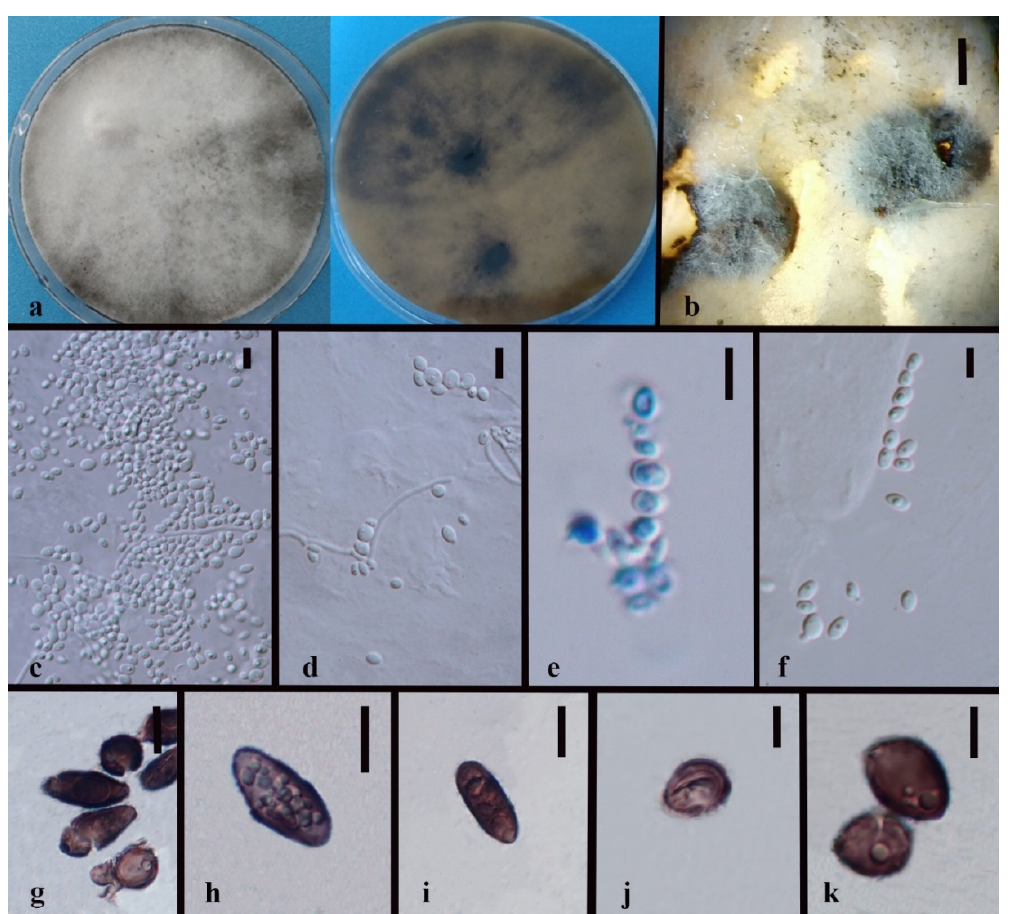
Figure 8. Hypoxylon investiens (MFLUCC 15-1155) ( a ) Colony on PDA (left-front view, right-reverse view). ( b ) Aggregated conidiomata. ( c – f ) Conidia. ( g – k ) Ascospores. Notes: ( b ) on PDA, ( c – f ) on WA (slide culture), ( g – k ) on MEA. Scale bars: ( b ) = 1 cm, ( c – f ) = 5 μ m, ( g – k ) = 10 μ m. Culture characteristics—Colony on PDA superficial, white to brown, velvety, mycelia gather unevenly, with an entire edge, reverse brown to black, and radial. Growth rate: 7